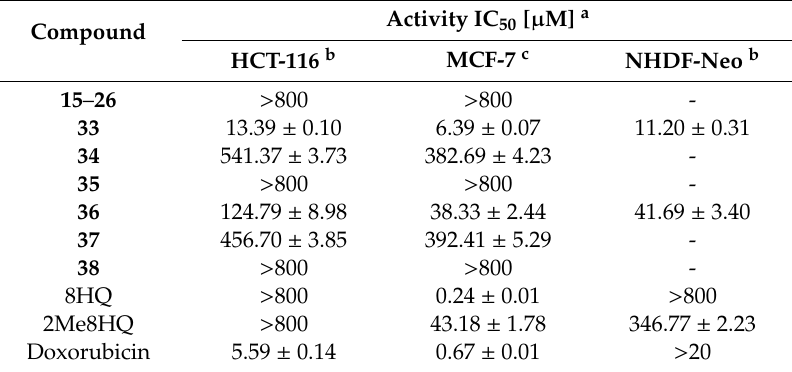
Table 1. Summary of cytotoxicity of substrates used for